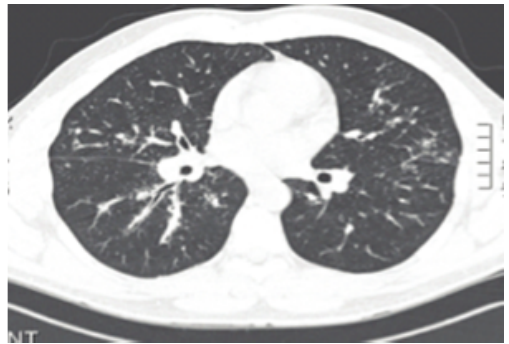
Figure 2: Pulmonary computed tomography showing bilateral hilar adenopathy and parenchymatous infiltration.